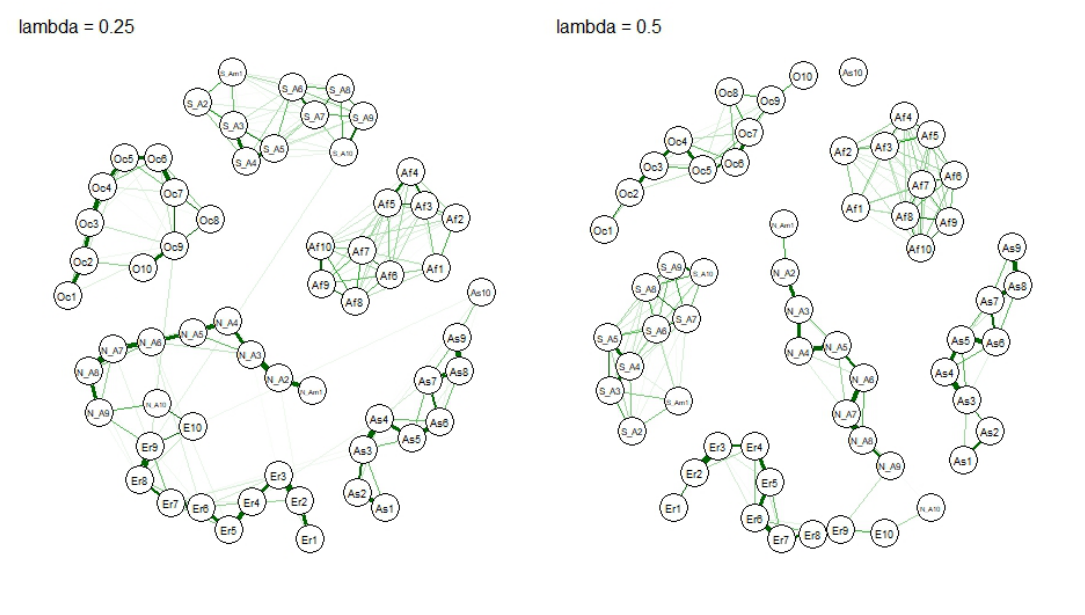
Figure 5. GLASSO partial correlation networks [varying lambda], 2/2.